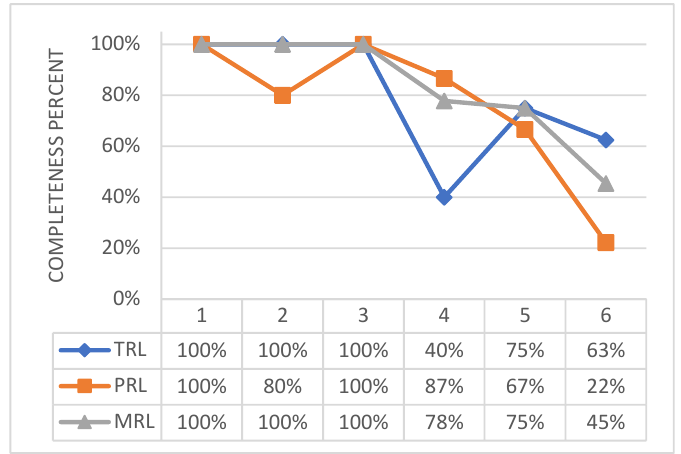
Figure 16. Technological, programmatic, and manufacturing level of maturity of the adaptive winglet actuation system.